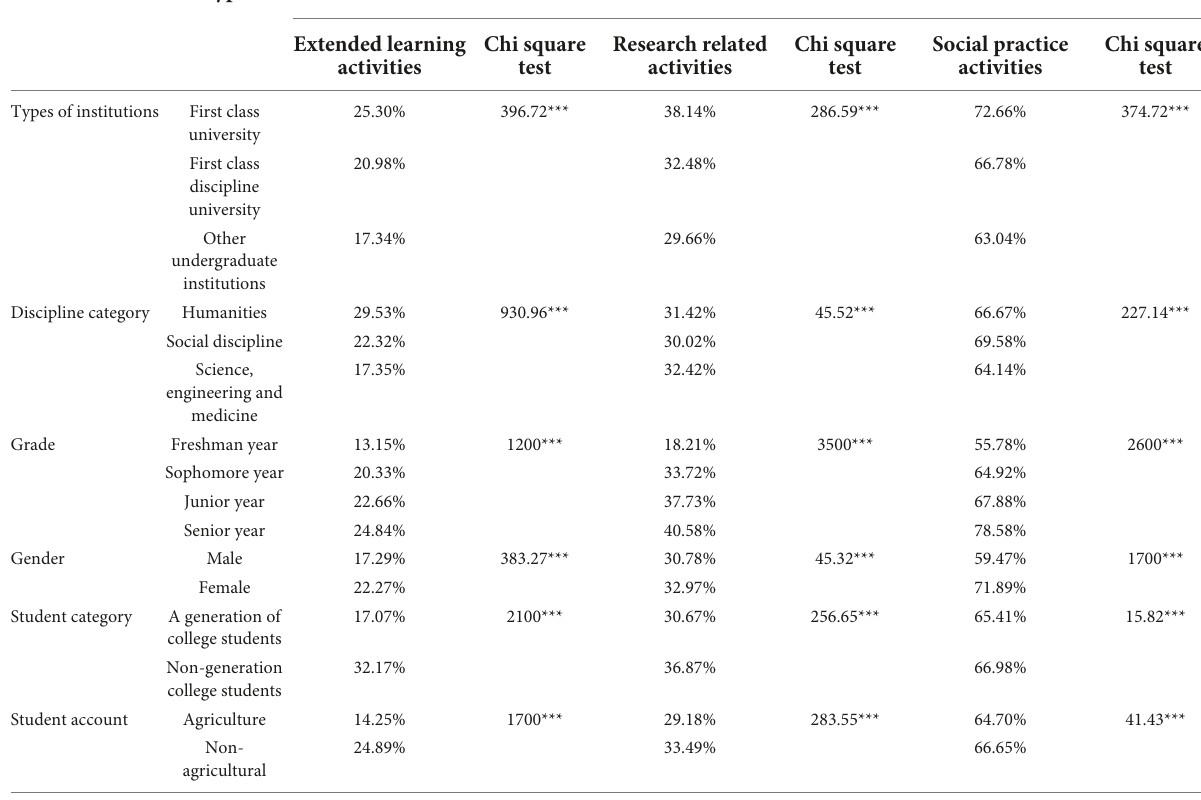
TABLE 3 Details of students from different backgrounds participating in HIPs.